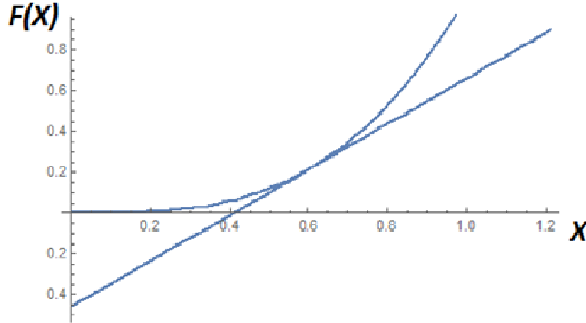
Figure 3: The curve with its tangent space in the Fractional Plane